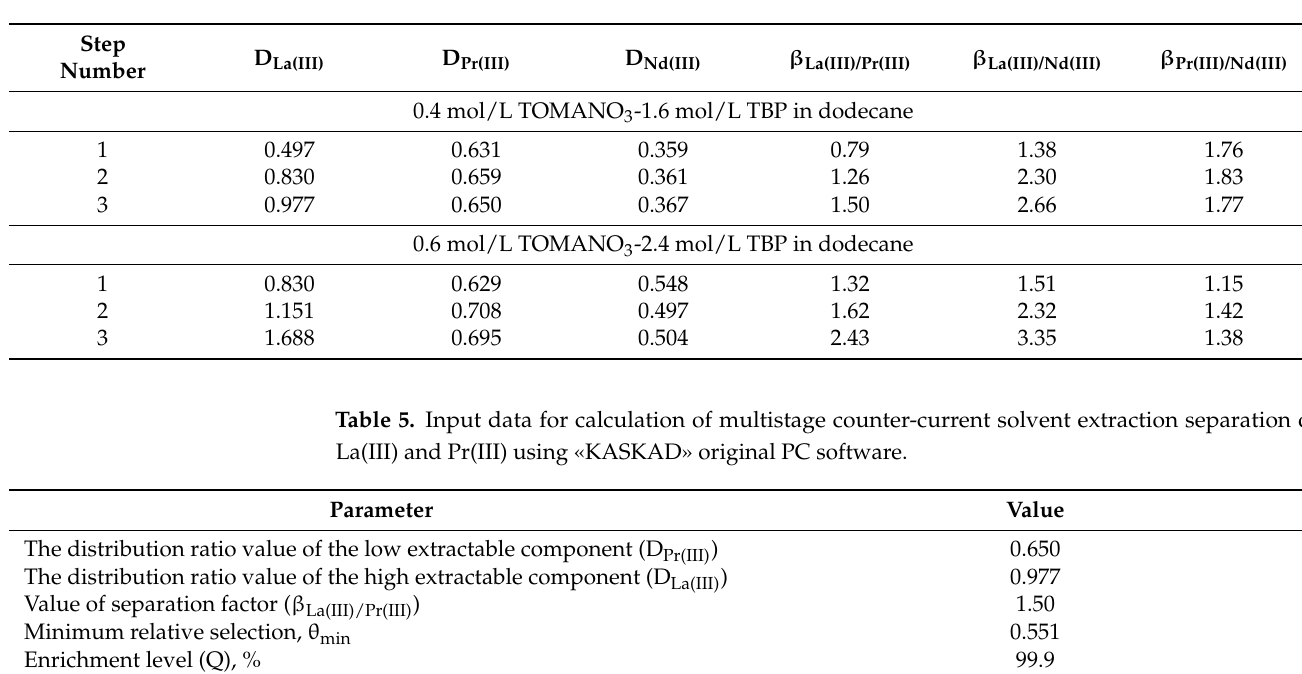
Table 4. Values of D Ln and β Ln1/Ln2 during SE from a solution containing 258 g La(III)/L, 58 g